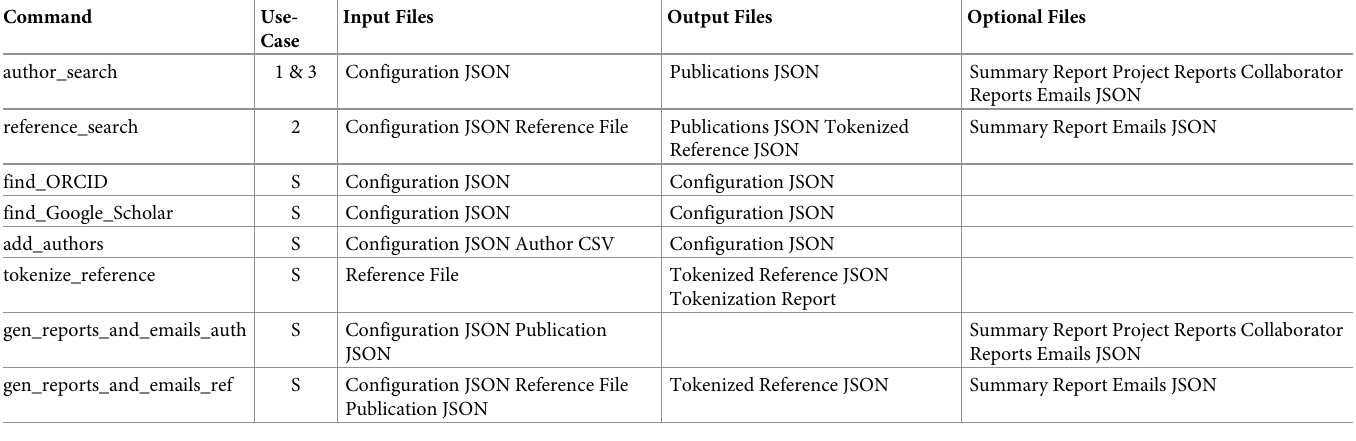
Table 2. Description of Academic Tracker commands.